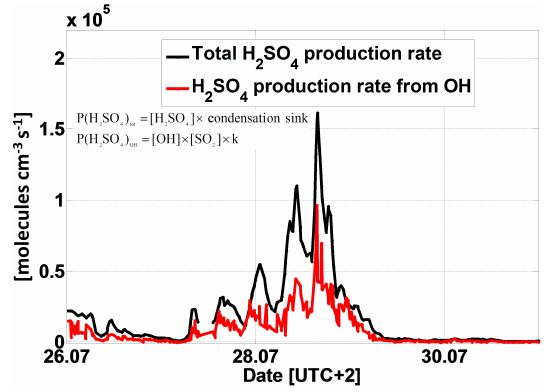
Figure 7. Background OH as a function of the sum of the prod- uct of the measured unsaturated VOC–ozone turn-over (Table S1), during the HOPE 2012 campaign. The blue points refer to the en- tire field campaign excluding tree cutting, which occurred between 1 and 3 August 2012, described by the red squares.